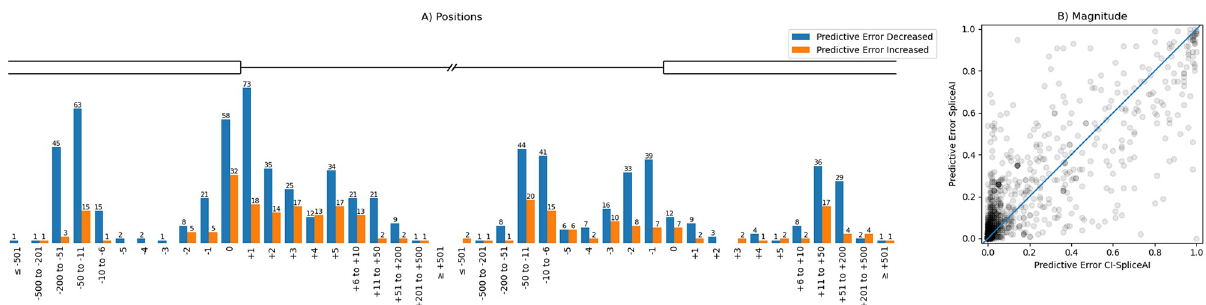
Fig 7. Comparison of the predictive error between SpliceAI and CI-SpliceAI on all 1,316 variants. The predictive error is the absolute difference between the most significant predicted annotation and the ground truth. 78% of predictions in CI-SpliceAI have a different output than when annotated with SpliceAI, out of which 73% have a smaller predictive error. (A) Predictions for CI-SpliceAI improved relative to SpliceAI for almost every position; there is no obvious bias where predictions worsened at a specific distance from a splice site, neither for the type of splice site nor the distance. (B) The magnitude of the change in predictive error. Variants on the identity line did not change their score; points lying above the identity line improved, points below worsened. The big cluster at the bottom left corner represents points where our algorithm shows improved confidence in correct predictions. A cluster of mispredicted variants of high confidence have worsened (top right corner).